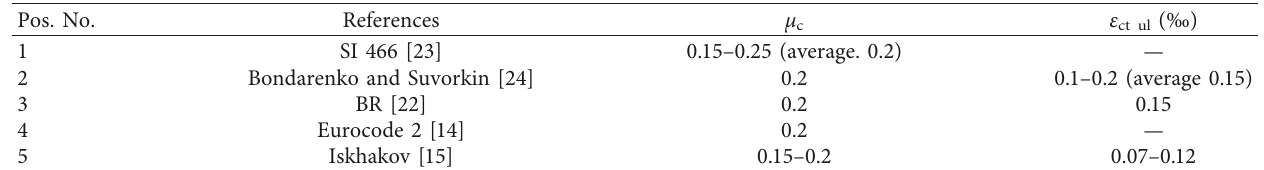
Table 3: Poisson’s ratio, μ